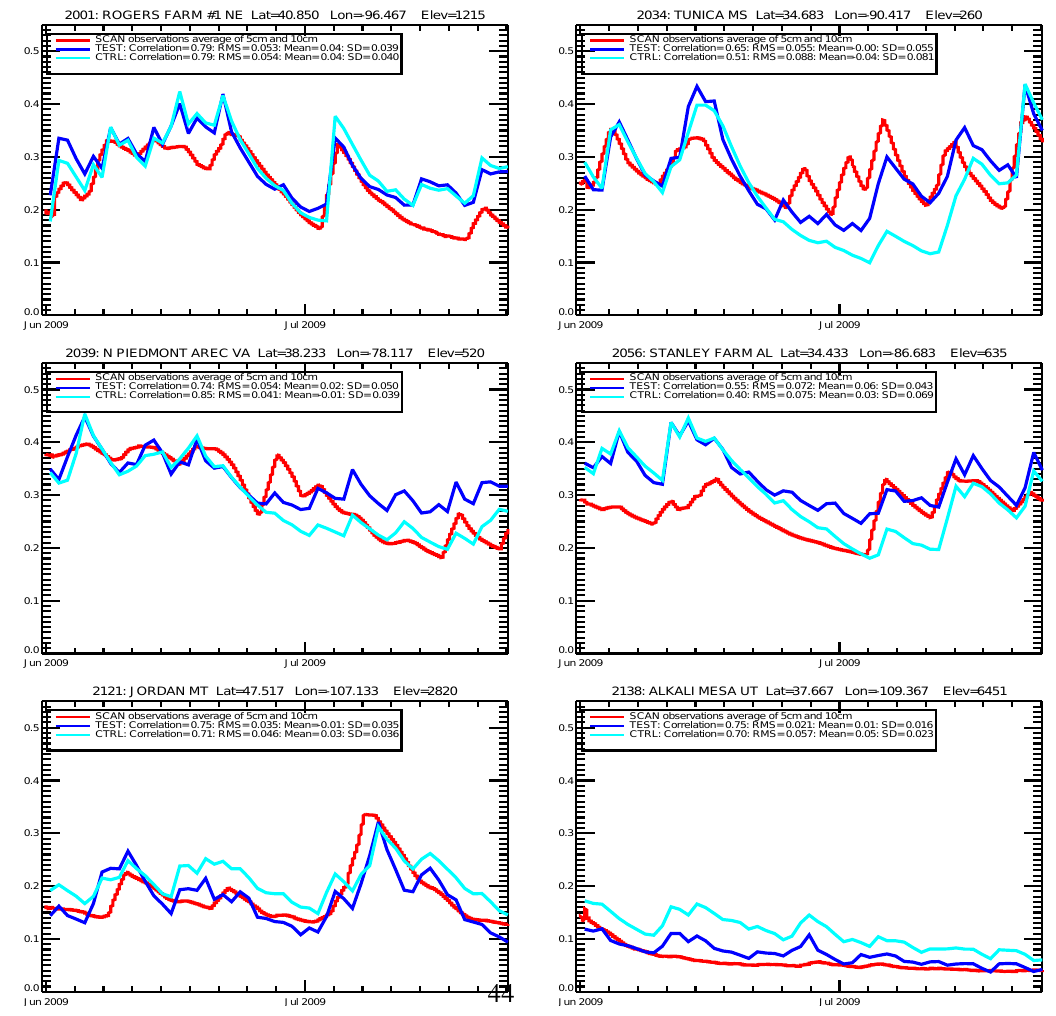
Fig. 13. Comparison of the UM level 1 soil moisture analyses with USDA SCAN observations for six selected sites during June and July 2009. The red curves shows the in-situ USDA SCAN soil moisture observations (mean of 5cm and 10cm measurements). The dark blue curves shows the UM level 1 soil moisture from the Test experiment of trial 1 that assimilates ASCAT surface soil wetness. The light blue curves shows the UM level 1 soil moisture from the Control experiment of trial 1. The selected sites are in the the states of Nebraska (NE; latitude=40.850, longitude= − 96.467, elevation==1215 feet), Mississippi (MS; latitude=34.683, longitude= − 90.417, elevation=260 feet), Virginia (VA; latitude=38.233, longitude= − 78.117, elevation=520 feet), Alabama (AL; latitude=34.433, longi- tude= − 86.683, elevation=635 feet), Montana (MT; latitude=47.517, longitude= − 107.133, elevation=2820 feet) and Utah (UT; lati- tude=37.667, longitude= − 109.367, elevation=6451